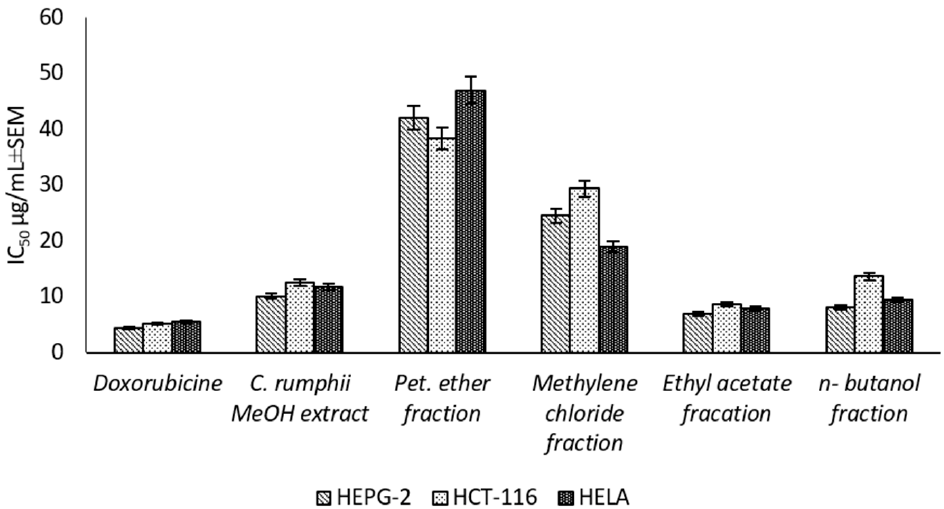
Figure 2. Cytotoxic effect (IC 50 ± SEM) of C. rumphii methanol extract and different fractions against different cell lines.